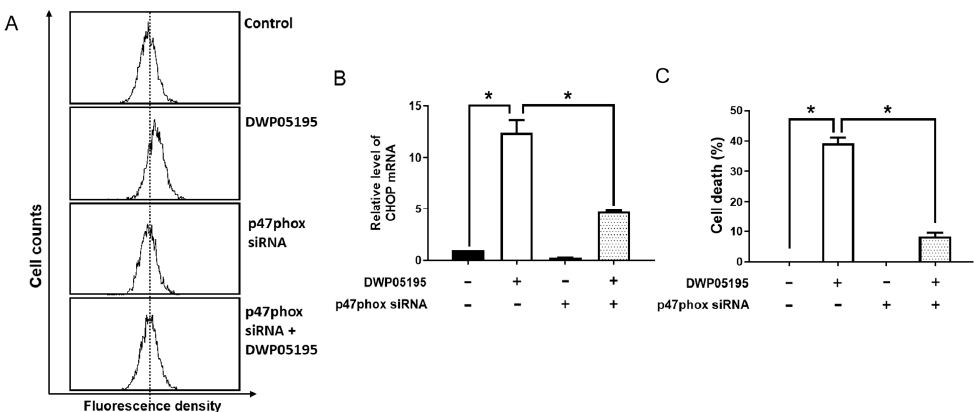
Figure 8. Involvement of NADPH oxidase activation in DWP05195-induced apoptosis. ( A ) A2780 cells were transfected with p47phox siRNA for 24 h and treated with DWP05195 (15 μ M) for 2 h. The cells were stained with DCFH-DA and analyzed by flow cytometry. ( B ) After knockdown of p47phox, cells were treated with DWP05195 (15 μ M) for 24 h. CHOP levels were measured by real-time RT-PCR. ( C ) After knockdown of p47phox, cells were treated with DWP05195 (15 μ M). MTT assay was performed to determine cell viability. Results are representative of at least three independent experiments. * p <